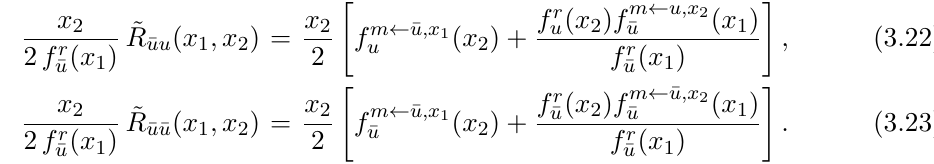
Figure 4 . Same as in figure 2 but for the u ¯ u and ¯ uu flavour combinations: a) R ∗ function, b) R ∗ response ¯ uu